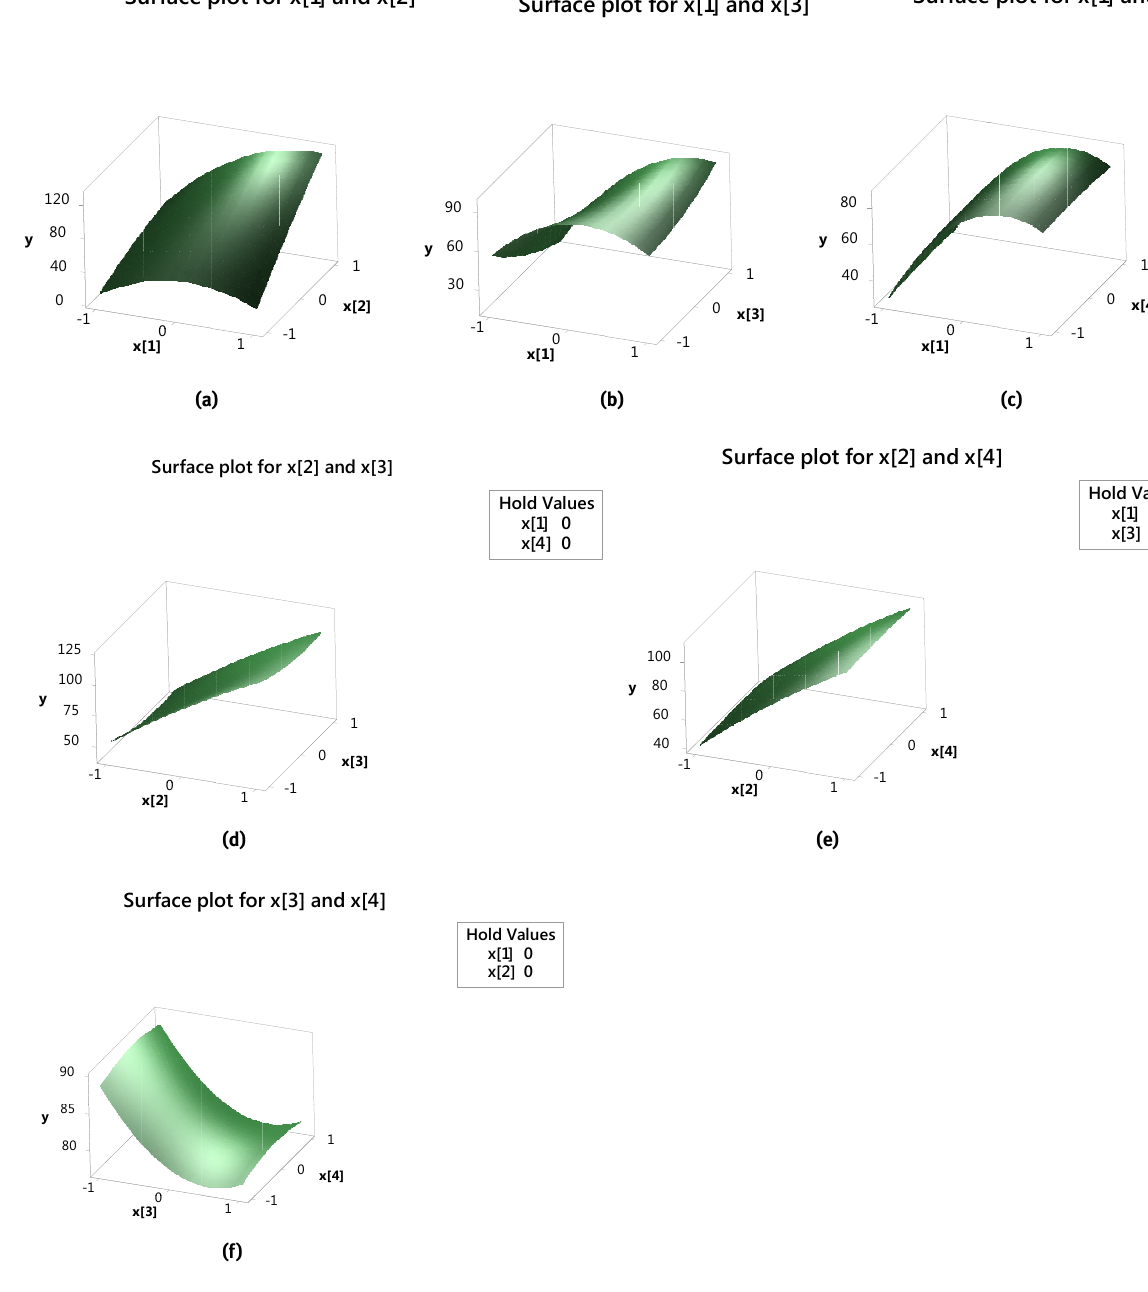
x and x ; (b) surface plot for 1 2 x ; x and (f) surface plot for 3 4 x and x ; (c) surface plot for 1 3 x and x ; (f) surface plot for 2 4